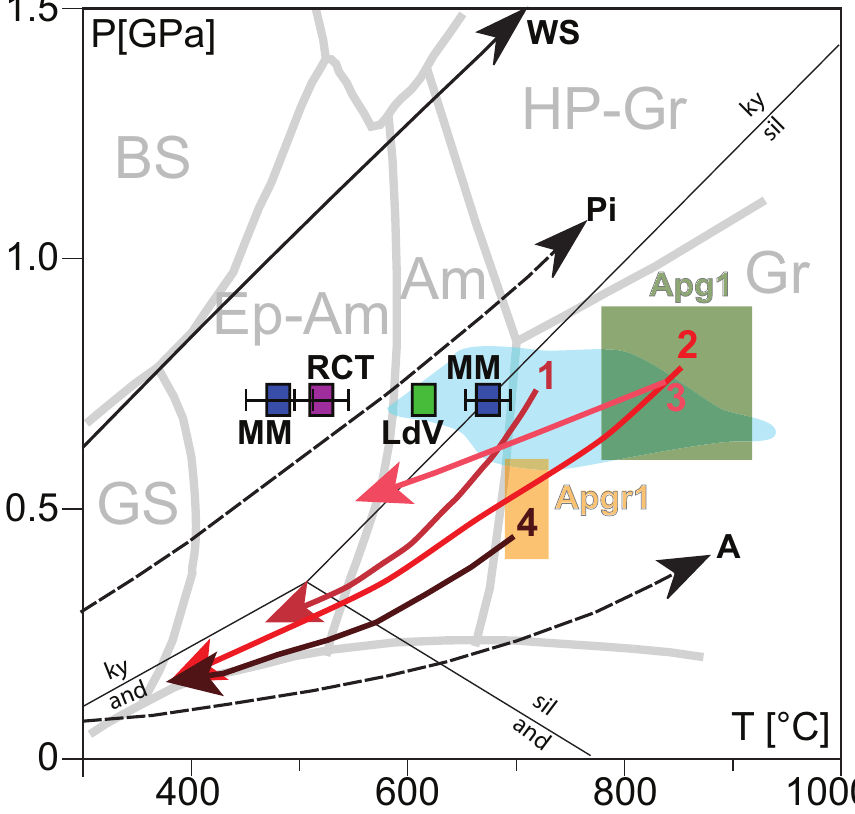
Figure 13. Pre-Alpine P-T conditions inferred for Lago della Vecchia (green square, LdV), Monte Mucrone (blue squares, MM), and Rocca Canavese (purple square, RCT) samples compared to the pre-Alpine PT-conditions (cyan shaded area; Table 1) and P-T-t paths from the literature (1: [12]; 2: [20,64]; 3: [64]; 4: [21]). Metagranitoids (Apgr1) and metagabbros (Apg1) emplacement conditions are also reported (Table 1). Metamorphic facies modified after [111–114]. Black arrows represent geothermal gradients traditionally associated to arc regions (A) and plate interior (Pi), warm subduc- tion complexes (WS), and cold subduction complexes (CS), as presented by [115]. Metamorphic facies abbreviations: Am, amphibolite; Am-Ec, amphibole-eclogite; BS, blueschist; Dry-Ec, dry eclogite; Ep-Am, epidote amphibolite; Ep-Ec, epidote-eclogite; Gr, granulite; GS, greenschist; HP-Gr, high pressure-granulite; Lws-Ec, lawsonite-eclogite; PP, prehnite-pumpellyite; Ze,